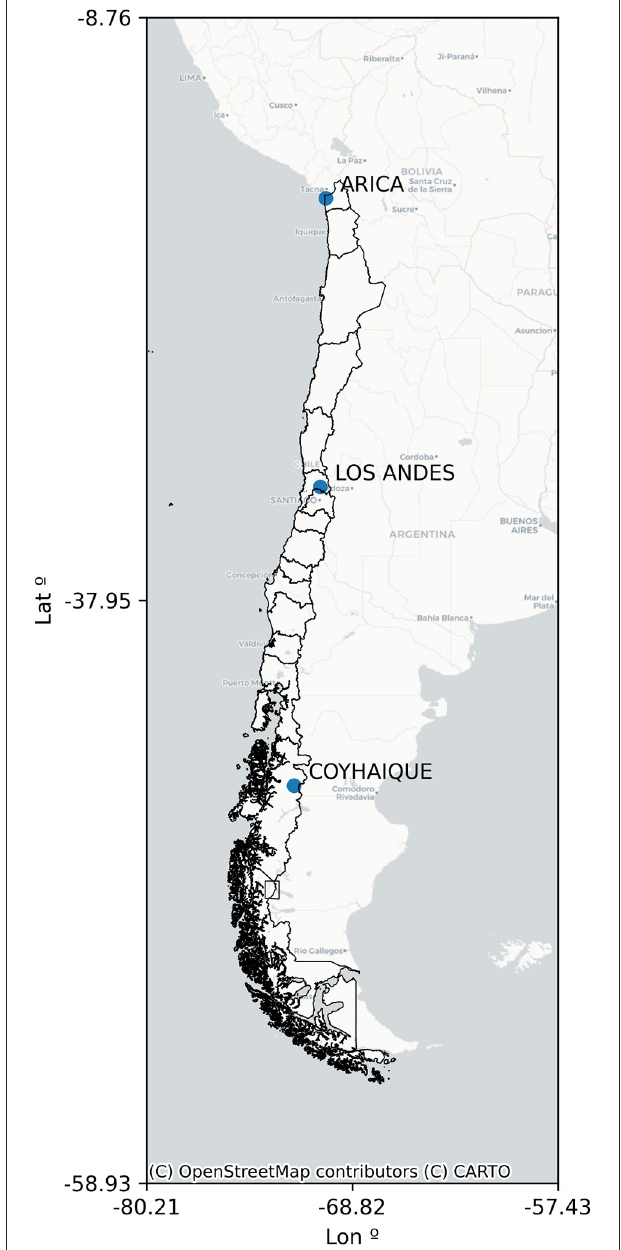
FIGURE 3 | Case studies